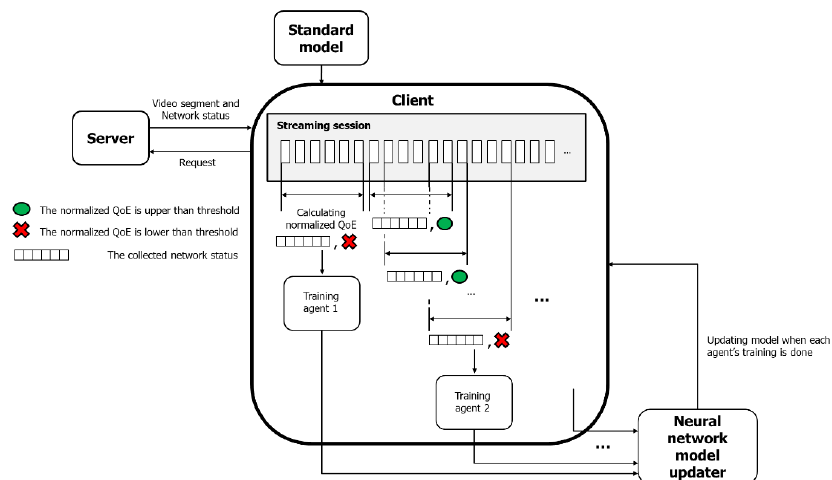
Figure 4. Operation of the proposed scheme.